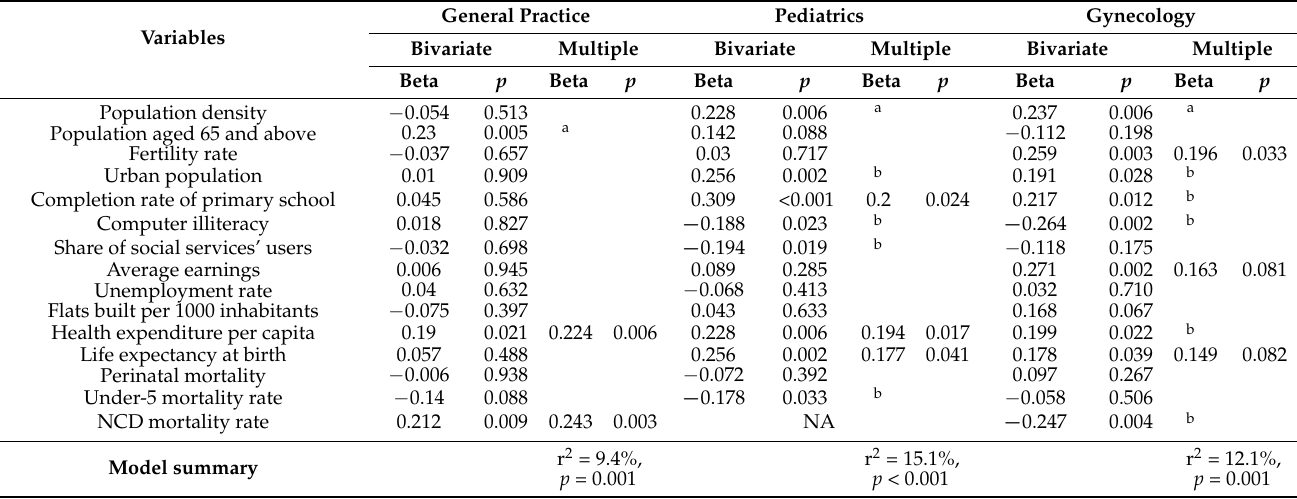
Model summary r